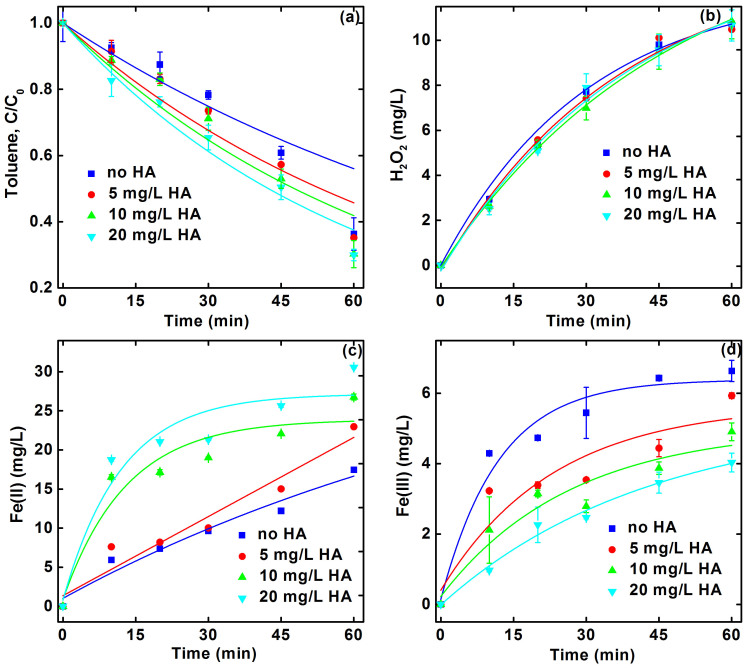
Effect of HA concentration on (a) toluene transformation, (b) H2O2 production, (c) Fe(II) accumulation, and (d) Fe(III) accumulation.The reaction conditions are based on 10 mg/L initial toluene concentration, initial pH 3.0, 50 mA current, 1 g/L Pd/Al2O3, and 10 mM Na2SO4 background electrolyte. Curves refer to pseudo-first-order kinetic fittings. Error bars indicate 95% confidence intervals.